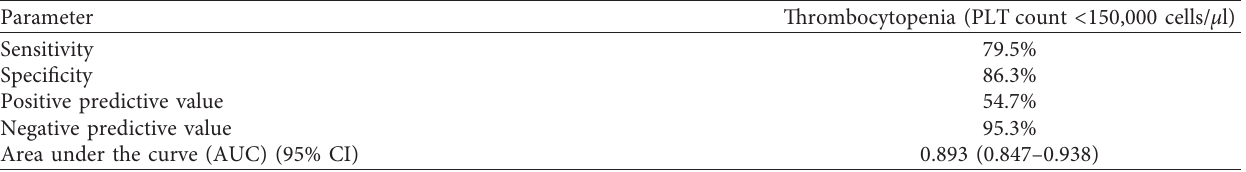
Table 3: Diagnostic values of platelet count to predict malaria in acute febrile